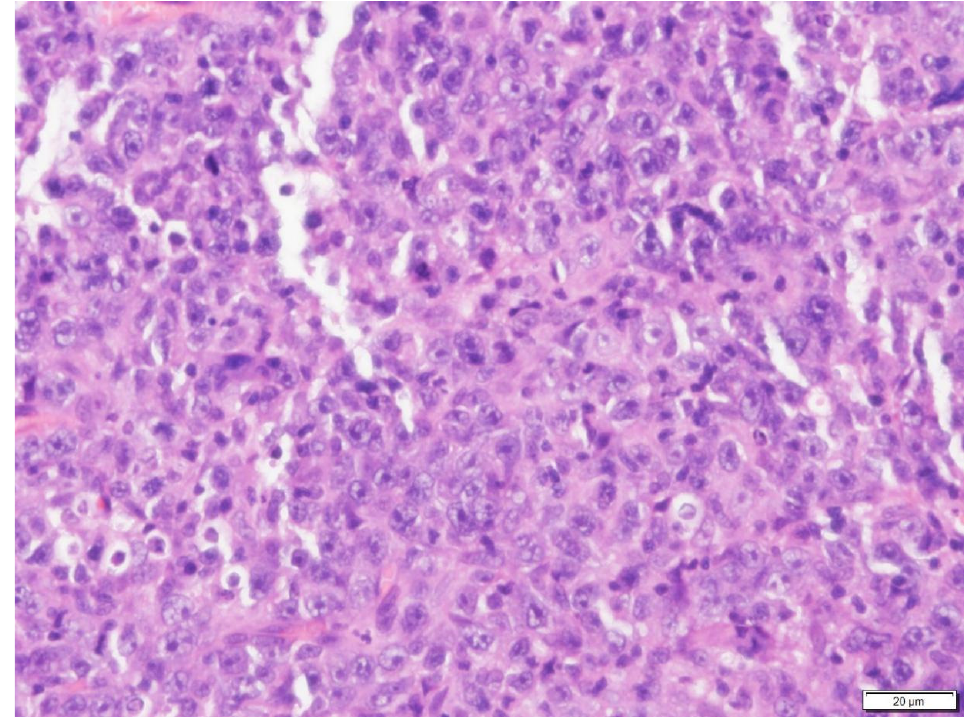
Figure 2. Higher magnification of the neoplastic cells in Case N.1. The cells were round to elongated, with minimal cytoplasm and vesicular pleomorphic nuclei and 1 to 2 distinct, magenta, medium nucleoli. H&E stain (400× magnification).